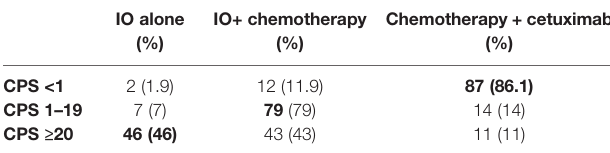
TABLE 3 | Clinical Case 1 — Preferred therapy according to CPS value.